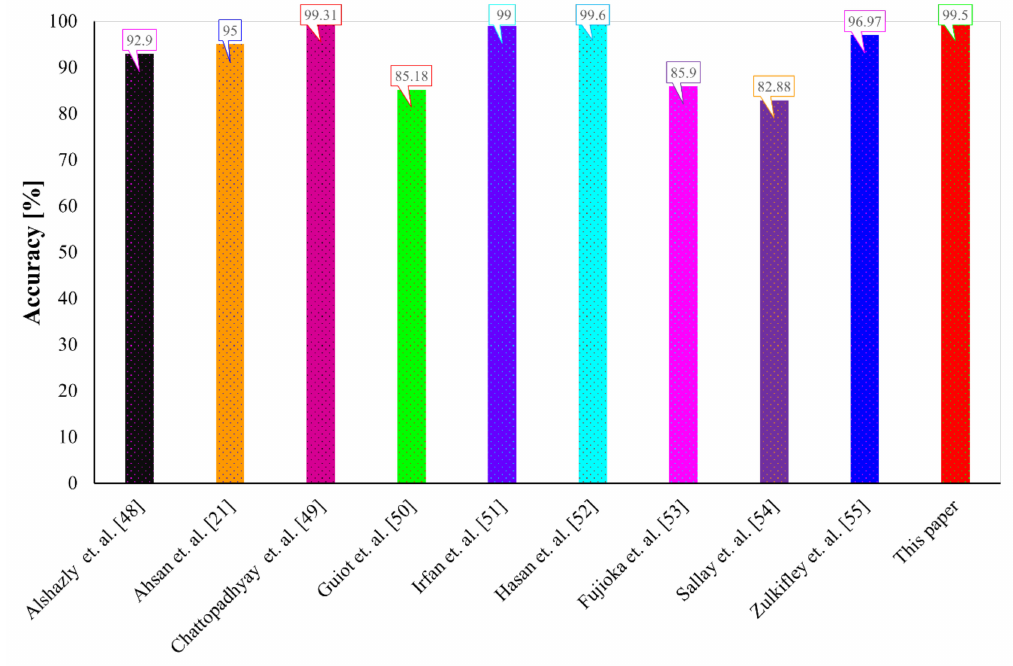
Figure 11. Comparison of the first-stage accuracy of the proposed method with others using CT scan images. The classification results of the X-rays and CT scans are shown in Figure 13 in the form of confusion matrices. The accuracy for X-ray images was 99.12%, while for CT scan it was